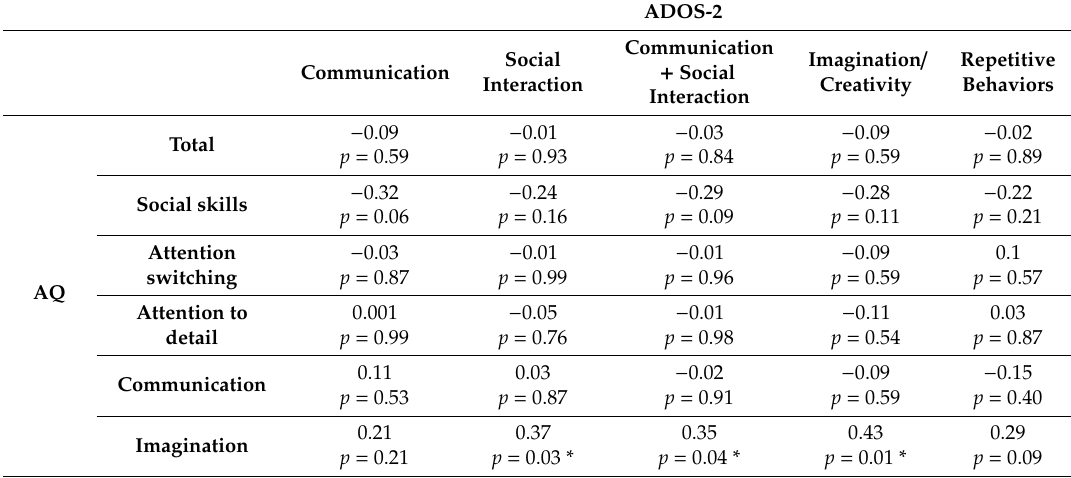
Table 4. Correlations between AQ and ADOS-2